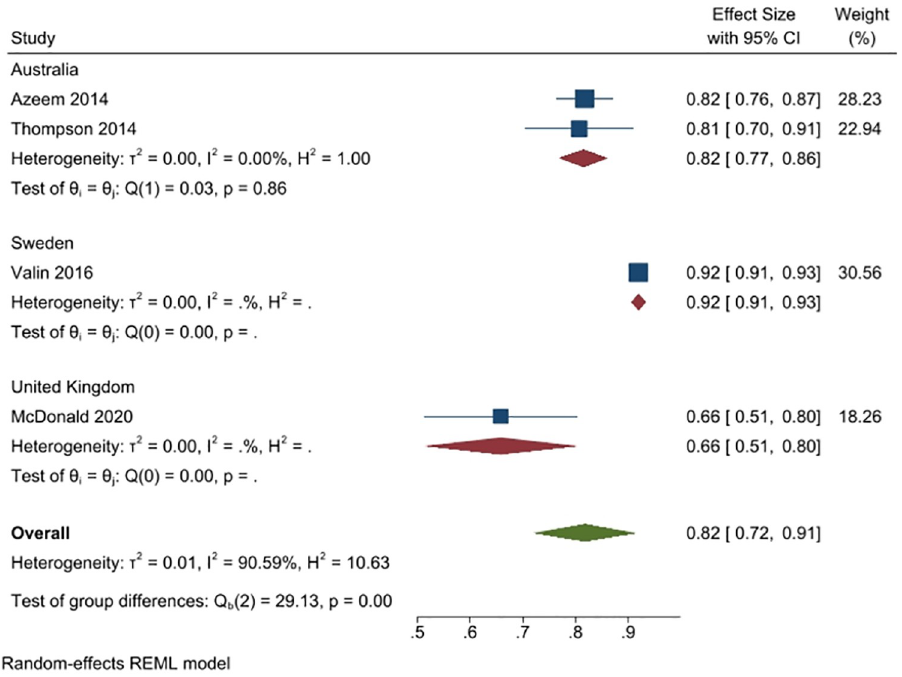
Fig 9. Percentage of respondents answering yes to the question whether antibiotic overuse impacts or decreases their effectiveness.